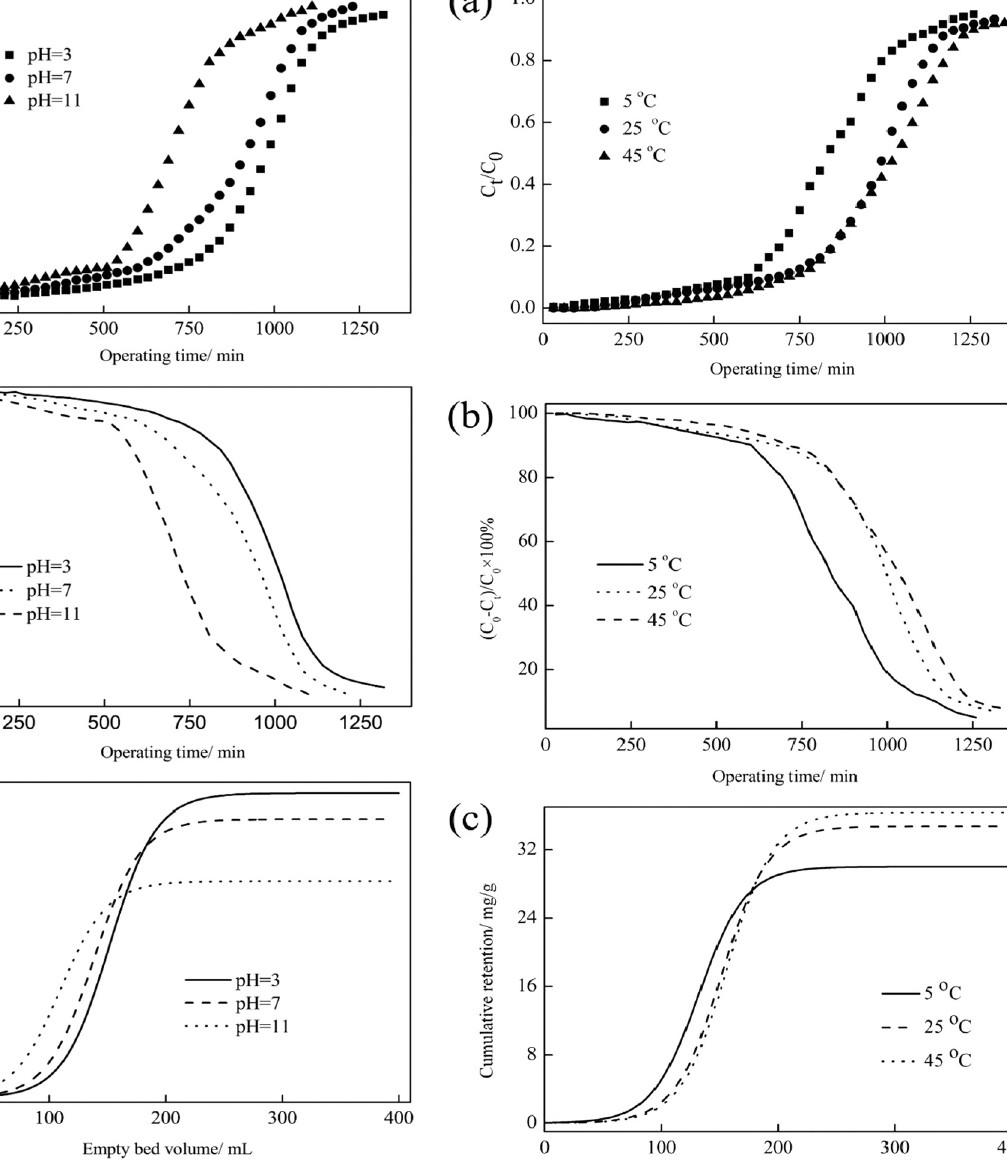
Figure 5: E ff ect of initial pH on the removal of ARG dye from aqueous solutions by fi xed - bed column packed with porous